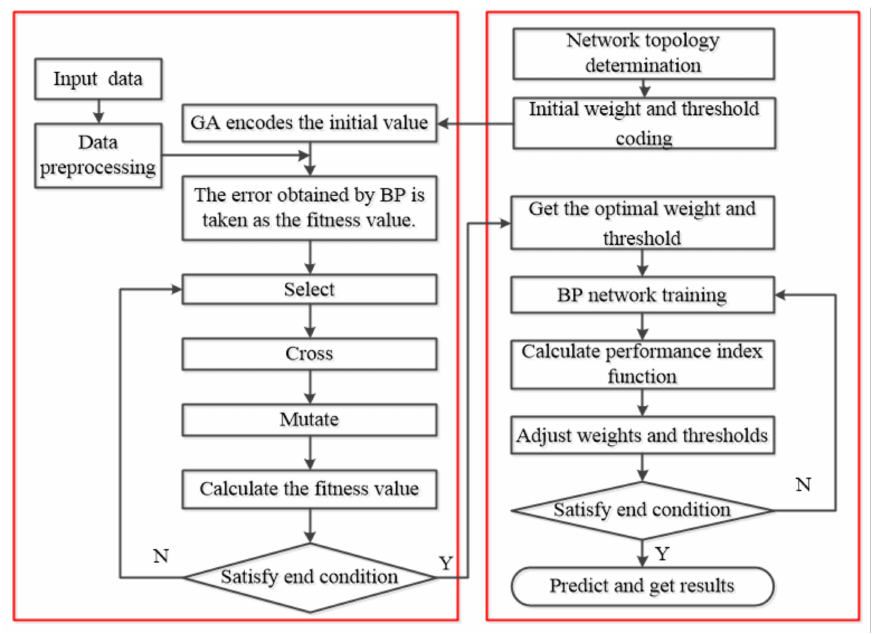
Figure 17. GA-BP algorithm flow chart.